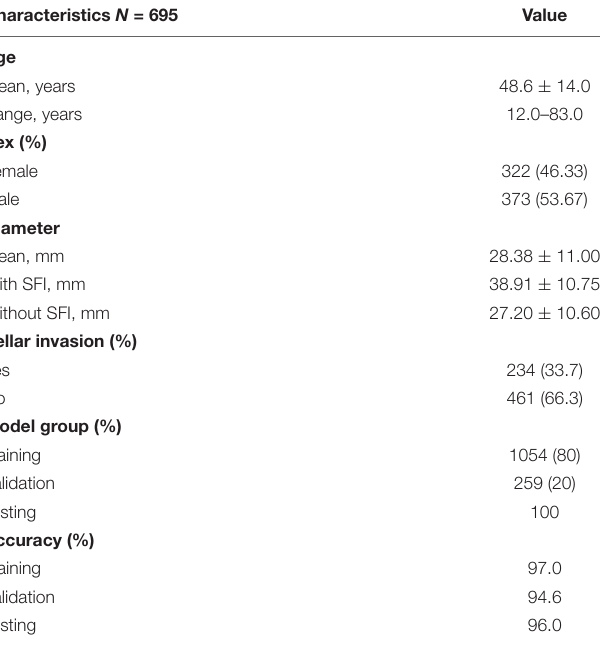
TABLE 1 | Summary of patient